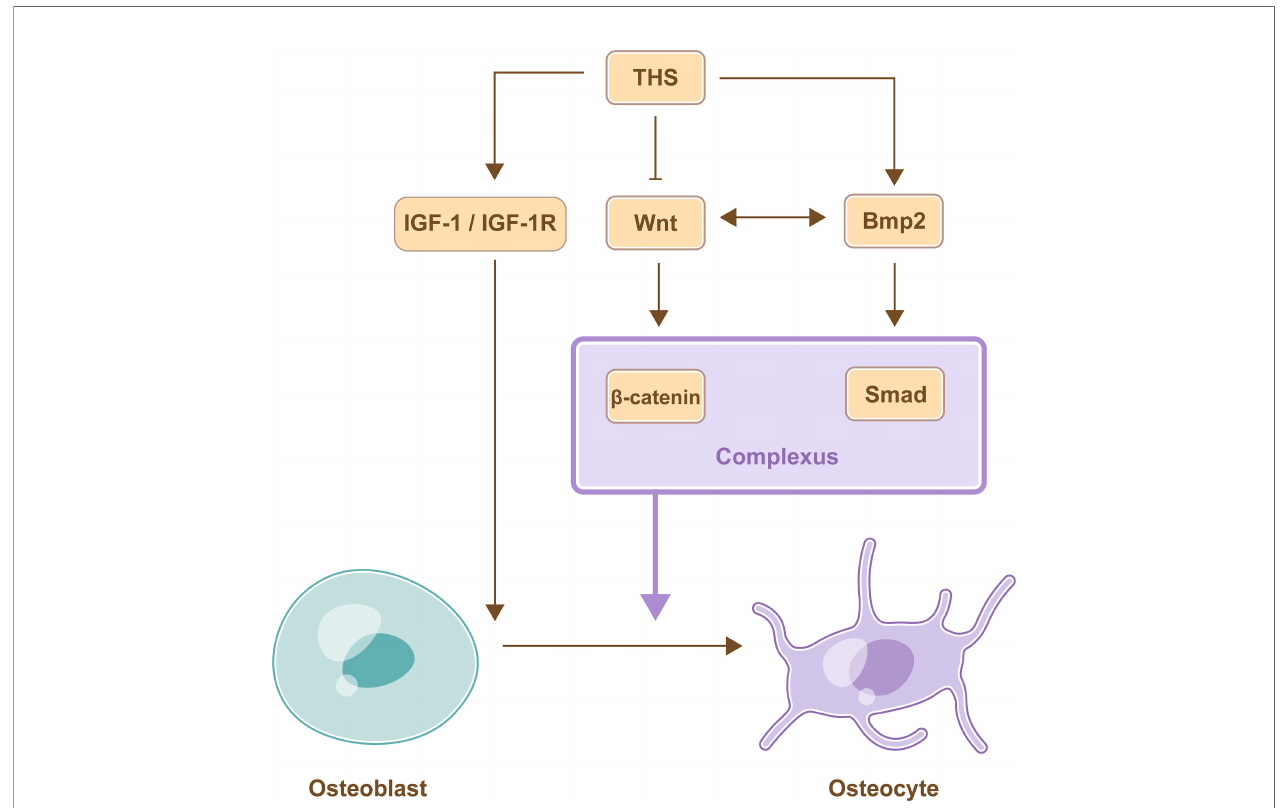
FIGURE 3 | TH-mediate regulation of osteoblast differentiation. THs promote the differentiation of osteoblasts by activating IGF-1 signaling pathway and BMP signaling pathway, while THs inhibit the differentiation of osteoblasts by inhibiting Wnt/ b -catenin signaling pathway. Furthermore, BMP signaling pathway and Wnt signaling pathway interact with each other and promote differentiation of osteoblast by forming a transcriptional